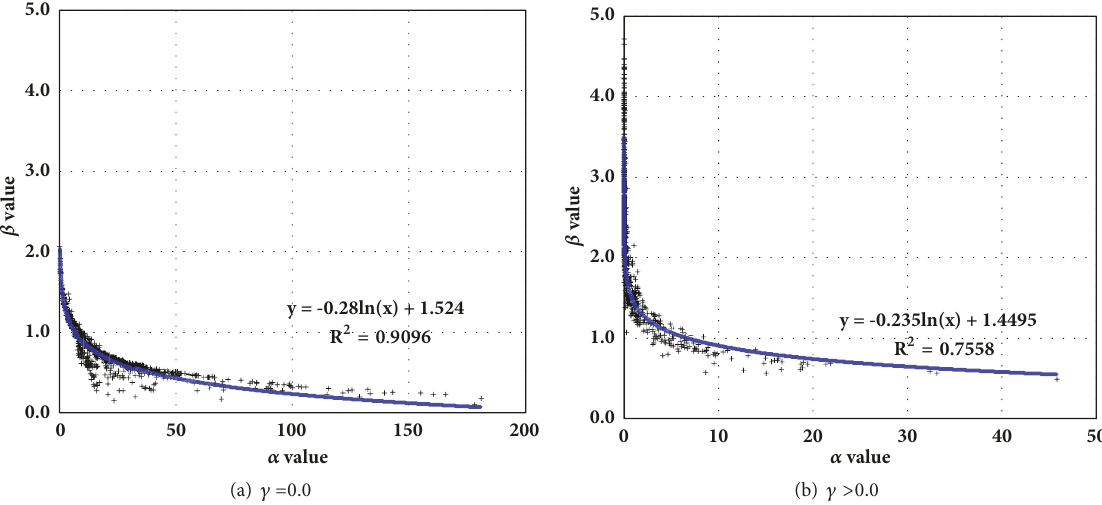
Figure 7: Relationships between 𝛼 and 𝛽 values according to 𝛾 values.